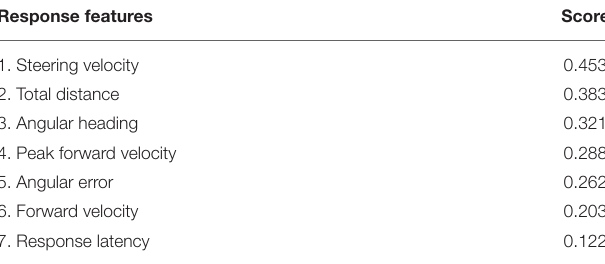
TABLE 1 | Response features ranked by mRMR feature selection analysis. Response features